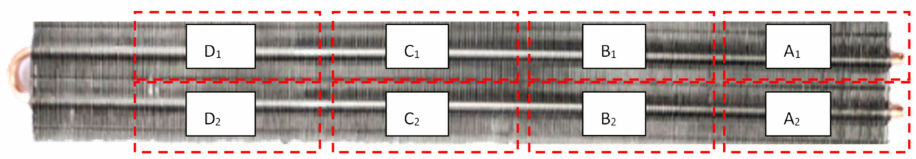
Figure 8. Eight samples in the tensile test cut along the dashed lines.